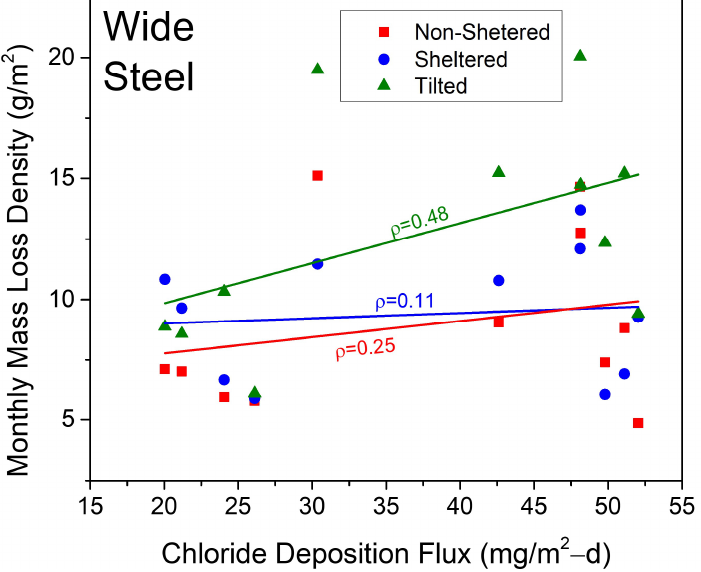
Figure 9. The effect of wet candle chloride deposition on steel mass loss density, on a monthly basis.